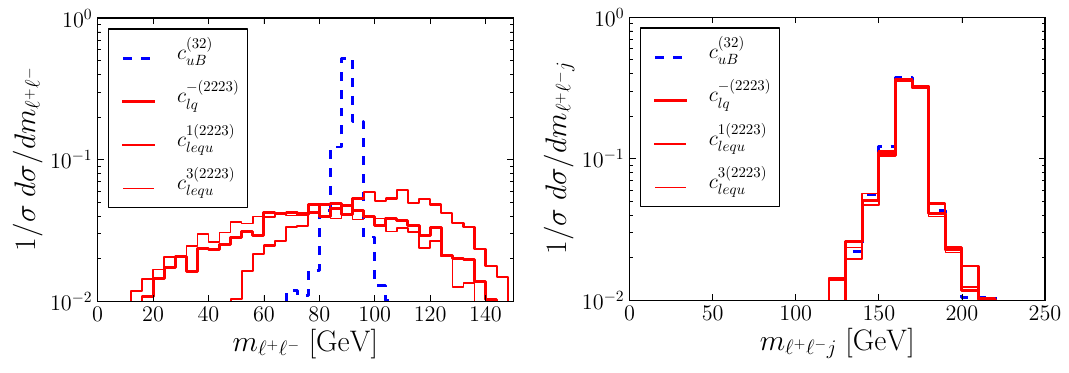
Figure 1 . Distribution of m ‘ + ‘ (cid:0) (left) and m ‘ + ‘ (cid:0) j (right) after the basic cuts of ref. [31] for four di(cid:11)erent operators.